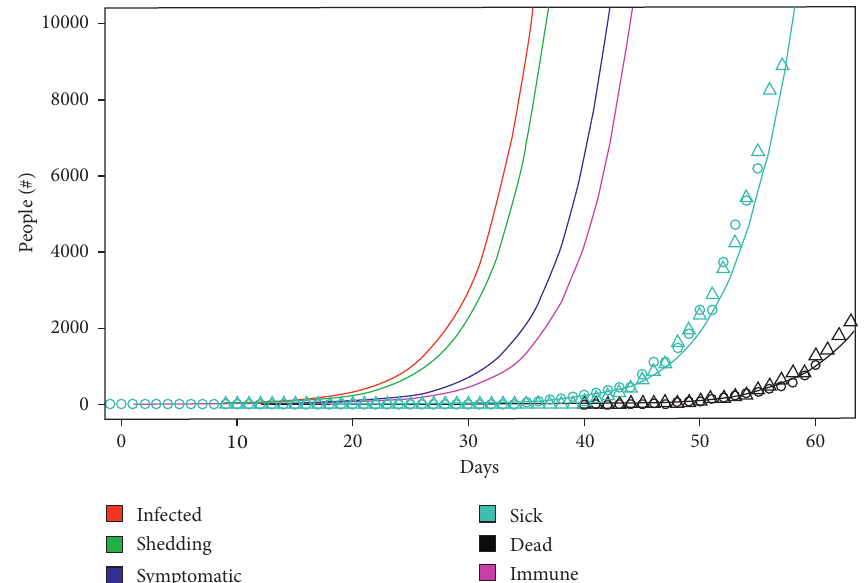
Figure 3: Model simulations overlaid with observational data of reported cases and mortalities from Italy ( △ ) and the United Kingdom